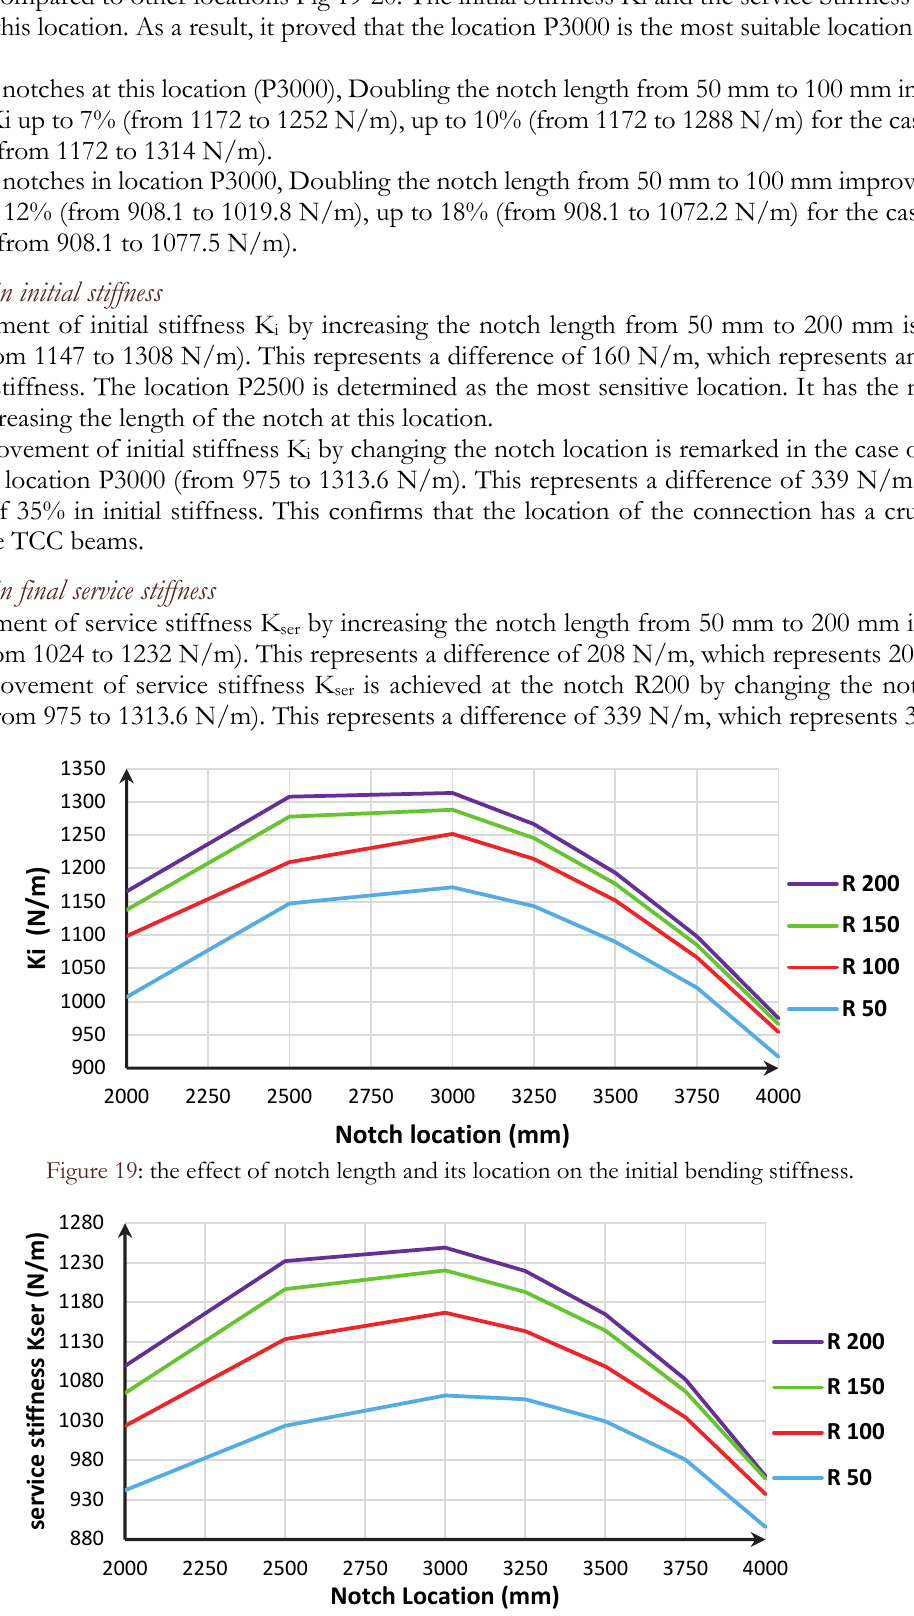
Figure 20: The effect of notch length and its location on the service bending